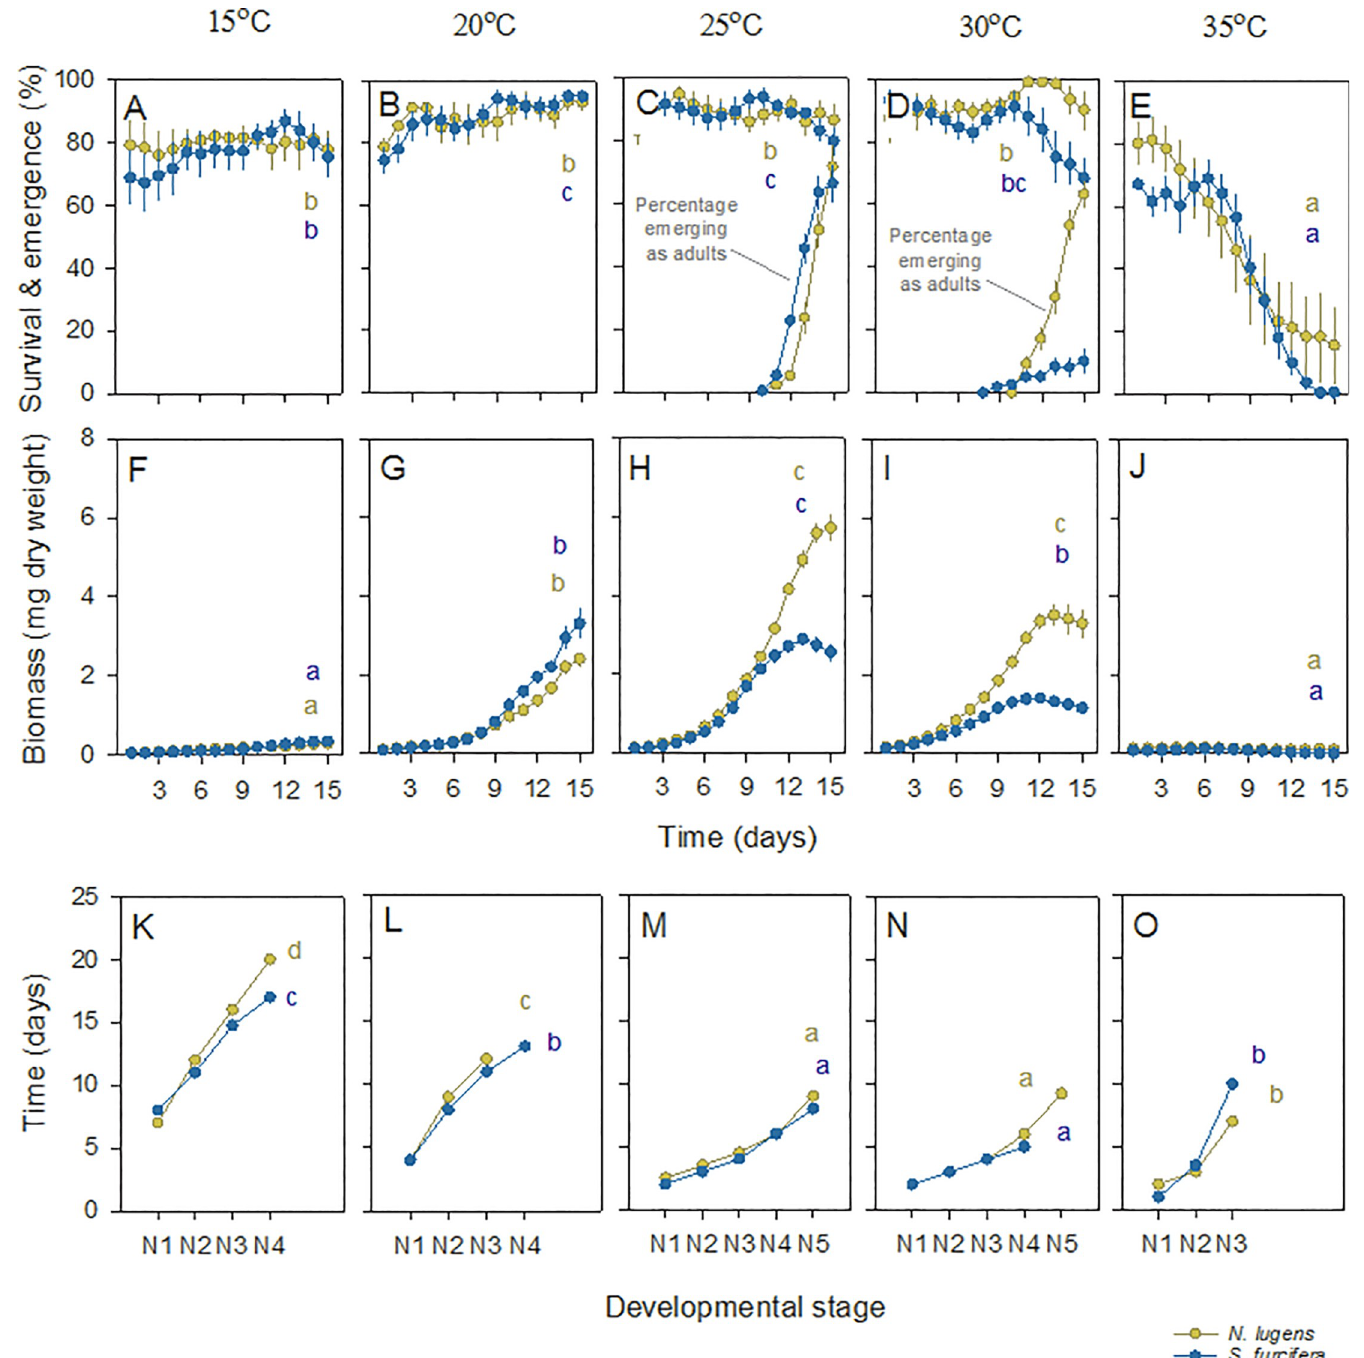
Fig 5. Effects of temperature on survival, weight gain and development of planthopper nymphs. BPH (brown symbols and lines) and WBPH (blue symbols and lines) nymphs were reared on IR22 (20 DAS) growing at 15˚C (A,F,K), 20˚C (B,G,L), 25˚C (C,H,M), 30˚C (D,I,N) and 35˚C (E,J,O). Results for nymph survival (A-E), nymph biomass (F-J), and nymph developmental times (K-O) are indicated. The proportions of nymphs developing to adults are also indicated (C, D)(N1 = first instar, N2 = second instar, etc.). Standard errors are included (N = 4). Lowercase letters indicate homogenous temperature groups (Tukey, P > 0.05). See also Table 4. Note that analyses for K-O only include